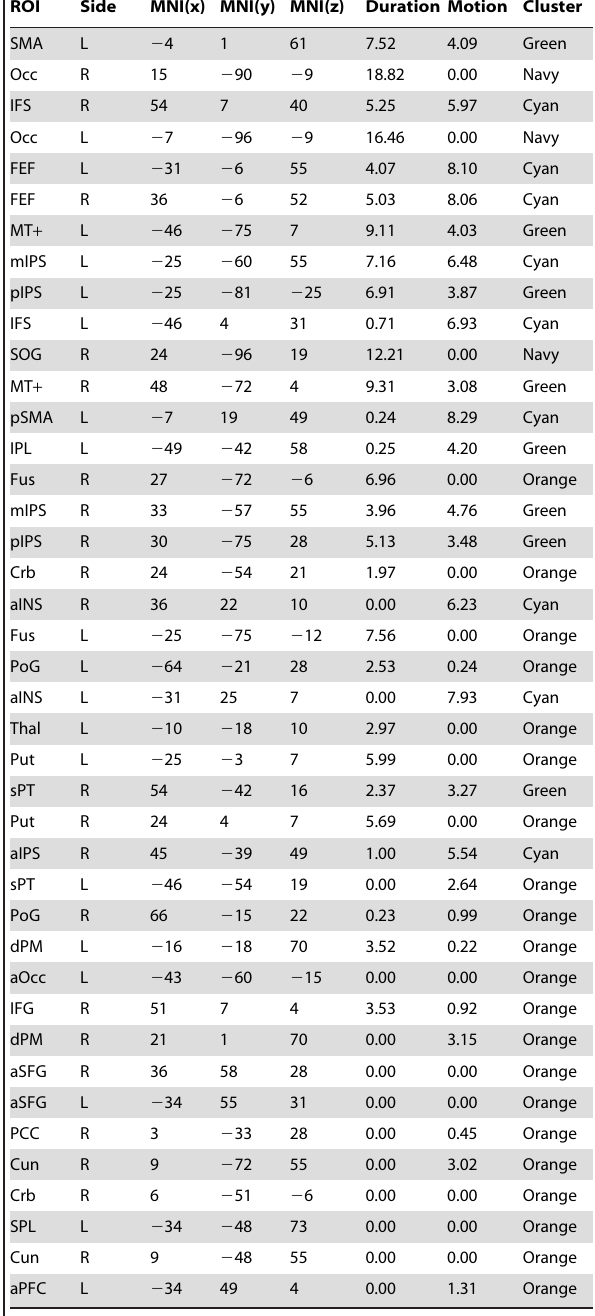
Table 1. Regions of interest, as indicated by names, MNI coordinates, Z-scores for the independent duration and motion coherence components, and cluster membership.